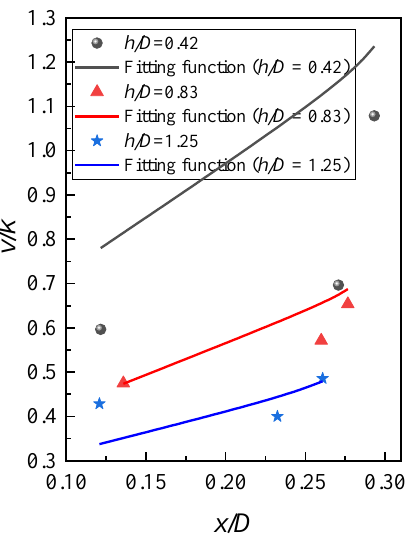
Figure 6. The hydraulic gradient with S = 1.5 kPa.